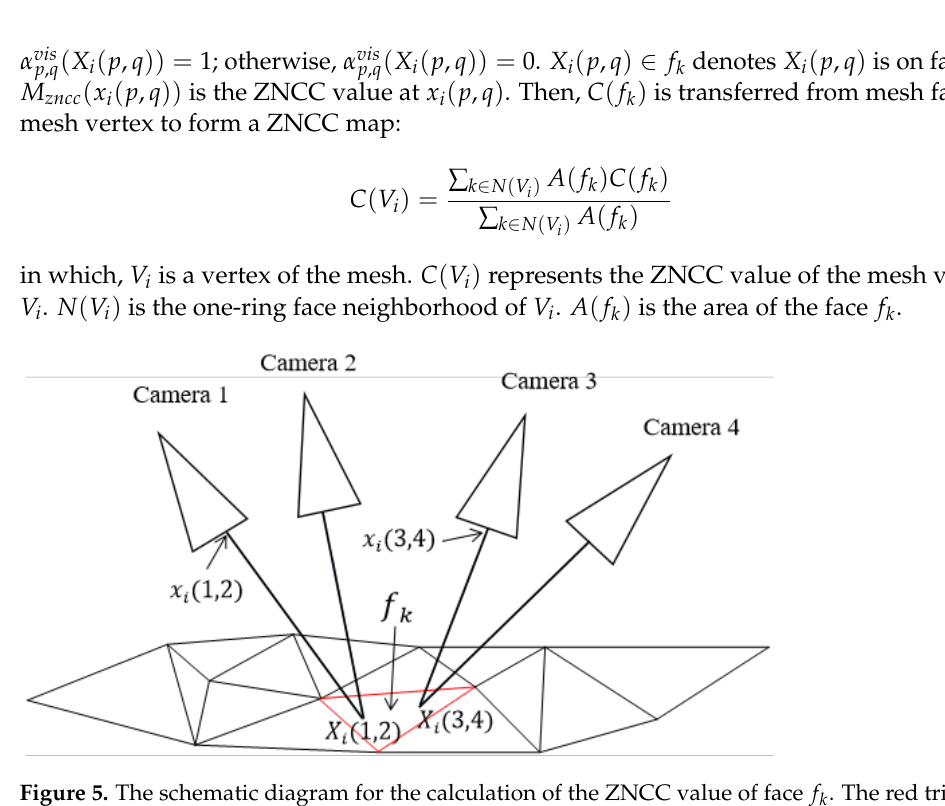
. The red triangle 𝑘 are considered for the ZNCC calculation, indicated 𝑘